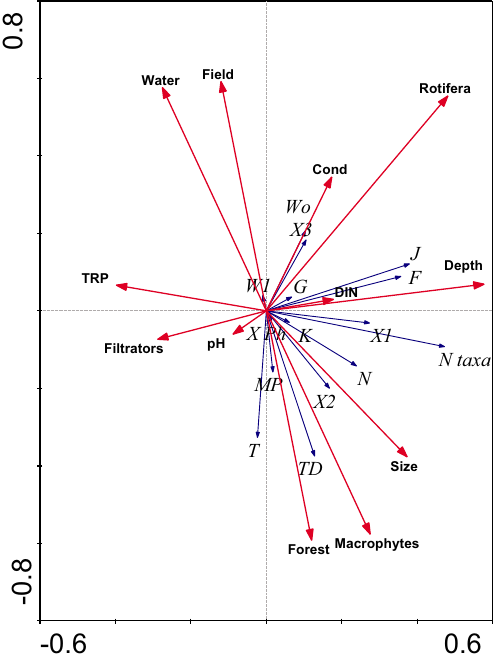
Figure 3. RDA diagram of the distribution of chlorophyte functional groups and number of taxa in relation to environmental factors in different types of catchment area (field and forest) and habitats (open water and macrophyte-dominated zones) of ponds.